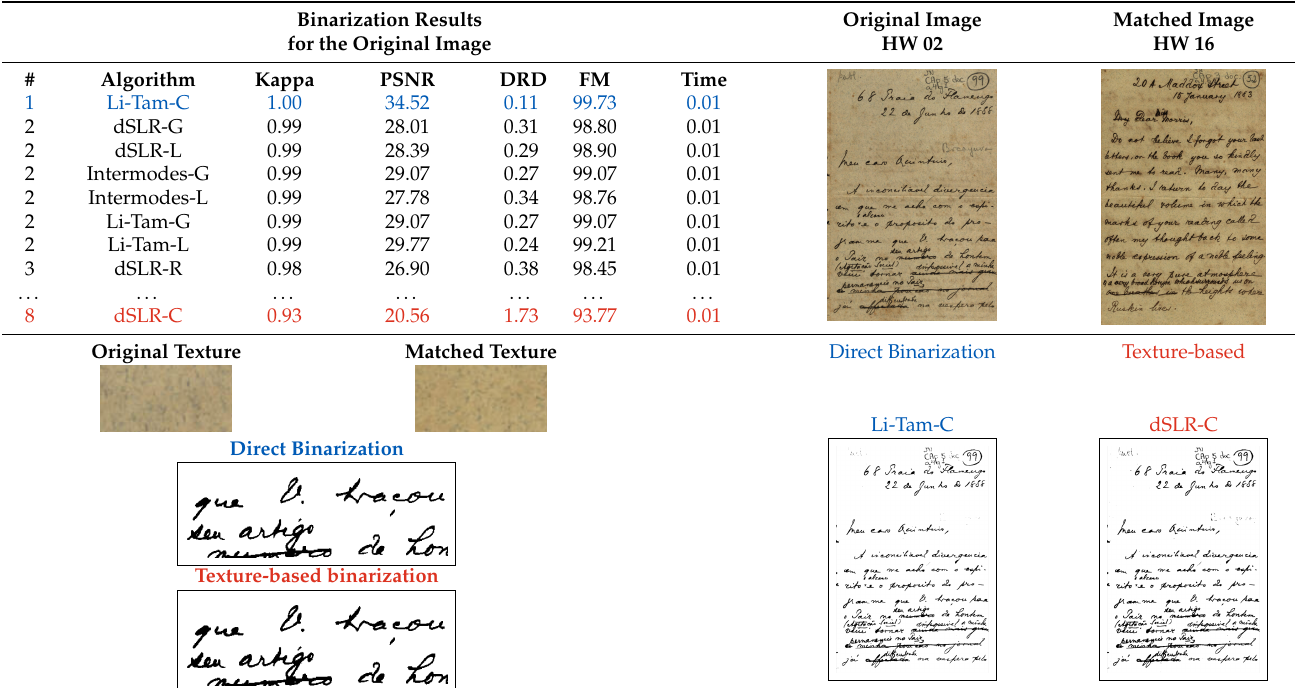
Table 5. Results for image matching with image HW